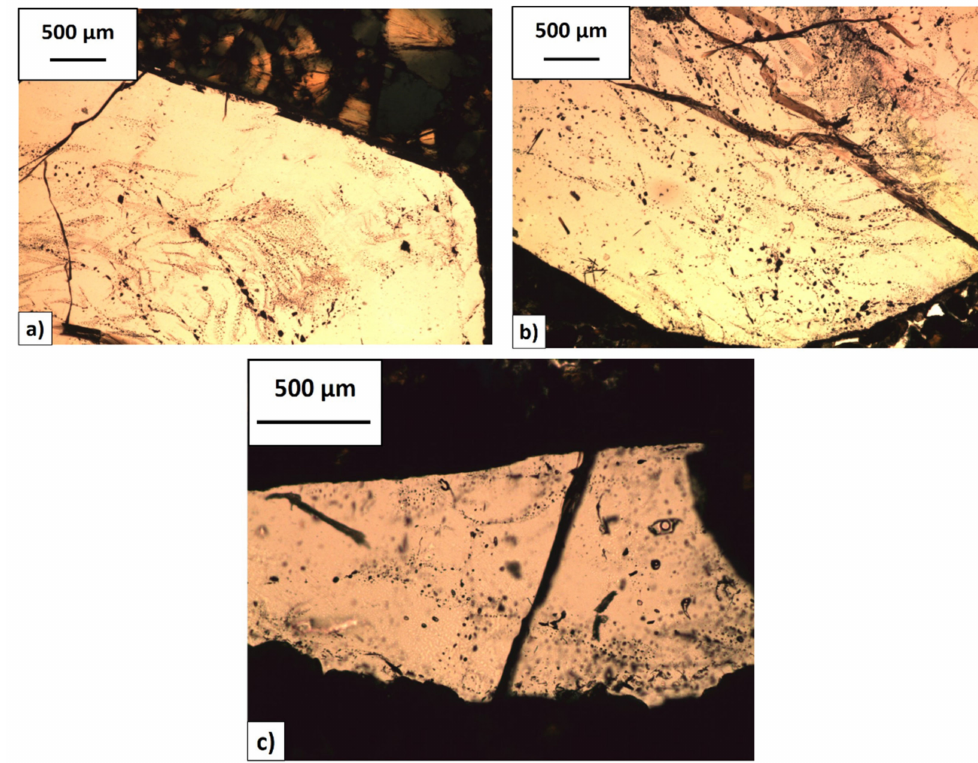
Figure 7. Photomicrographs showing: zonings and trails of fluid inclusions ( a , b ) and isolated fluid inclusions in sample SHS2 ( c ). Table 3. Petrographic characteristics of fluid inclusions observed in scheelite. Degree of fill by liquid water is an approximate range. Size is generalized, the biggest fluid inclusions is 160 µ m in the 3N1 sample (see photo Figure 8a). Total number of studied fluid inclusions was n = 190.